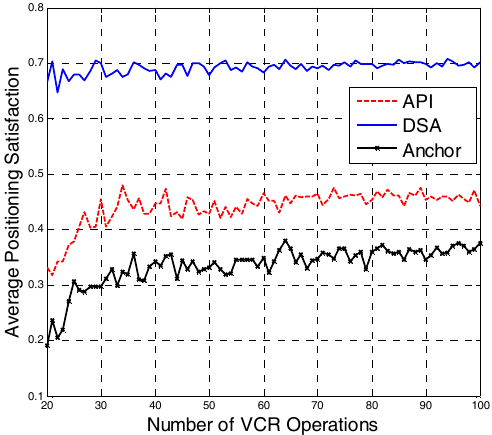
Figure 7. Average positioning satisfaction of different